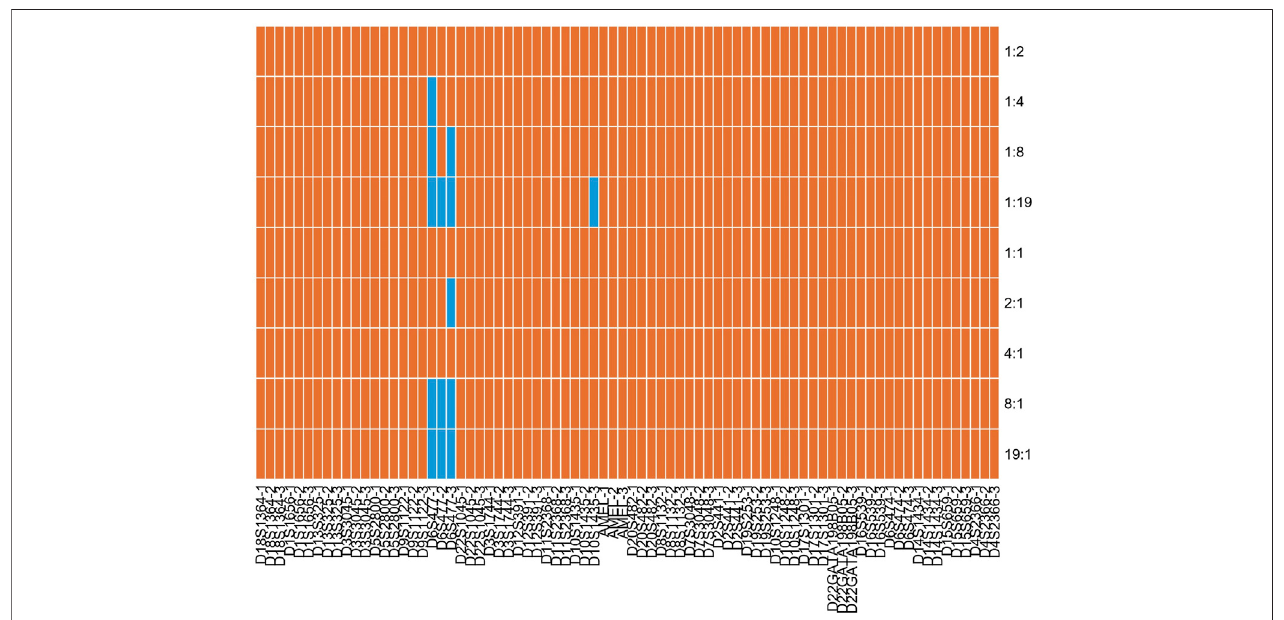
FIGURE 6 | Allele detection results of the STRtyper-27 comp kit for different ratios of 9948 and 9947A samples. Orange and blue blocks indicated complete and partial alleles detected, respectively.